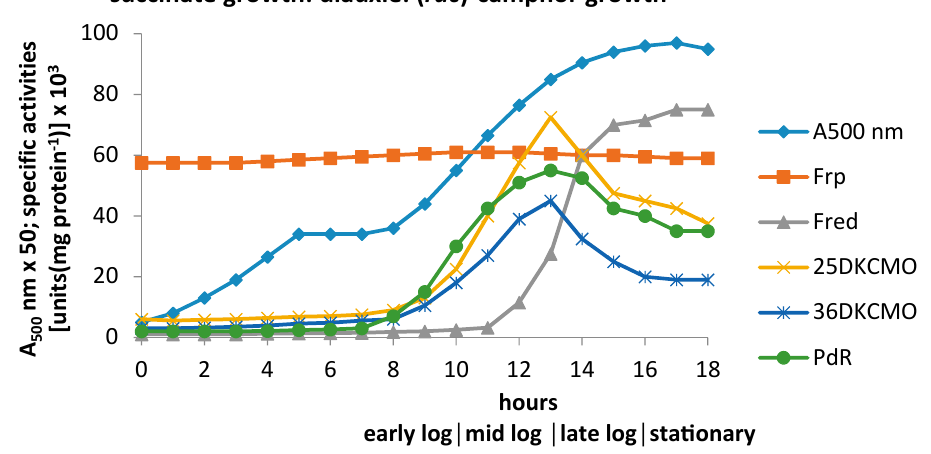
Figure 2. Changes in the optical density (A 500 nm) and the specific activity of key enzymes of ( rac )-camphor degradation during diauxic growth of P. putida NCIMB 10007 on a succinate plus camphor-based defined medium